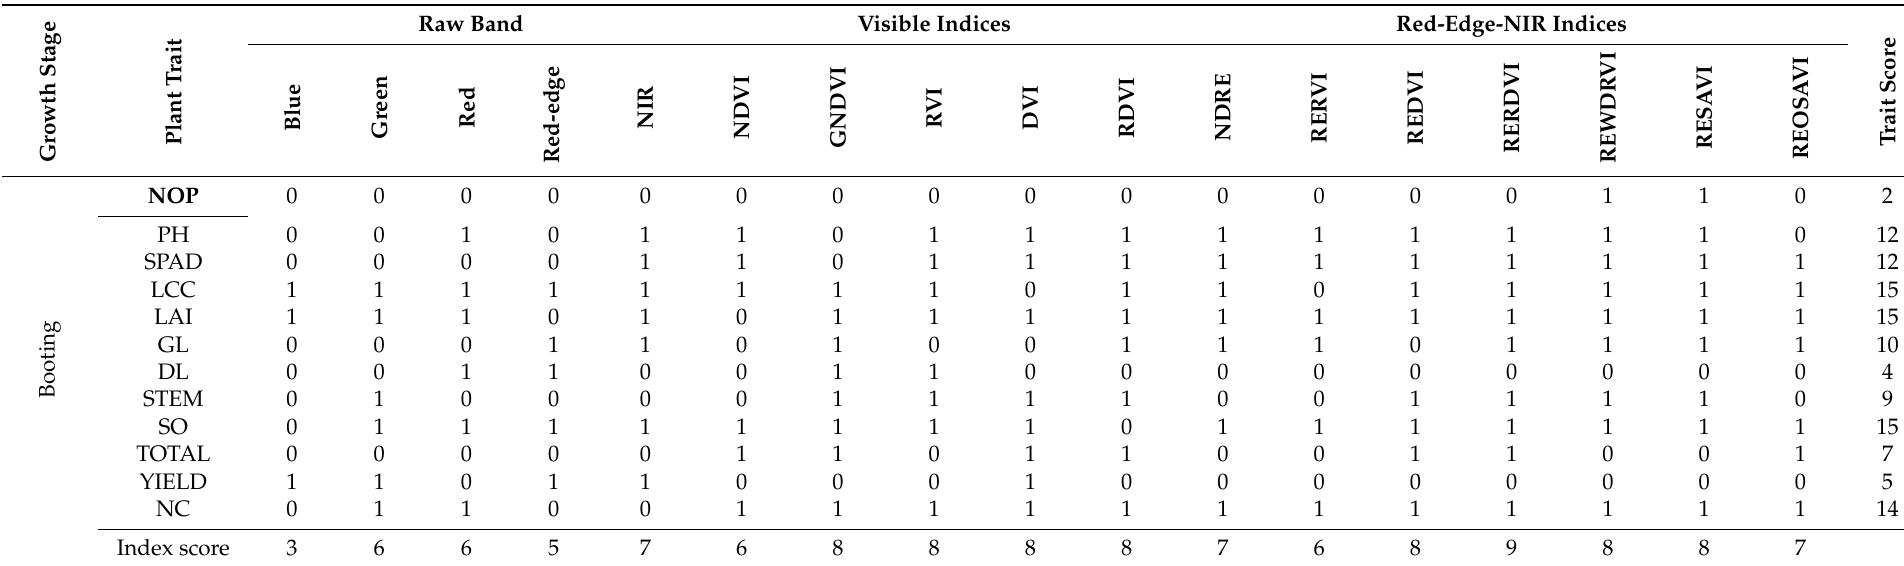
Table 5. Index and trait score for all plant traits and indices at